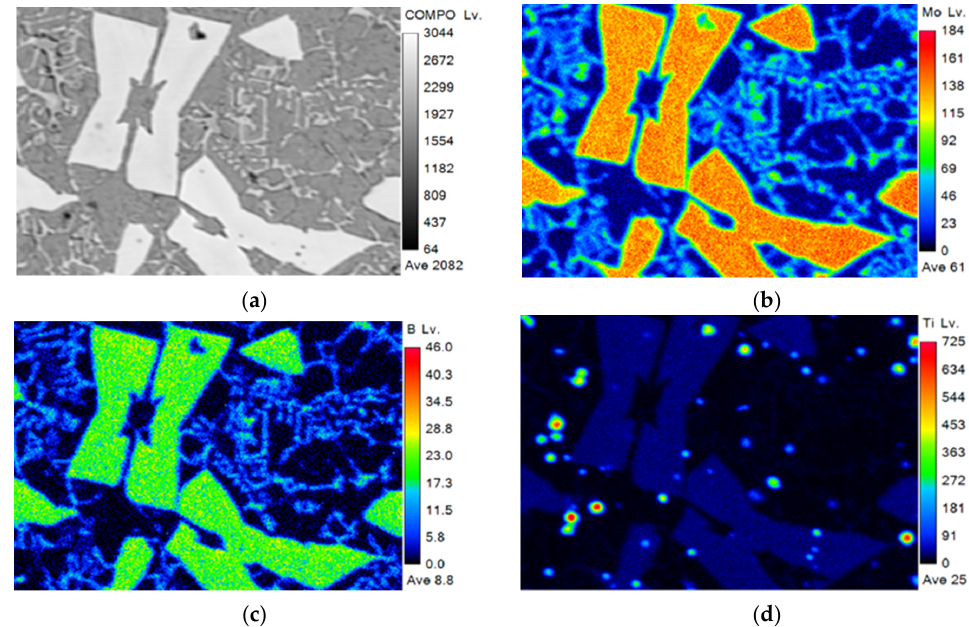
Figure 6. Element distribution images of cladding layer with 15% TiC added ( a ) BSE images ( b ) Mo ( c ) B ( d ) Ti.